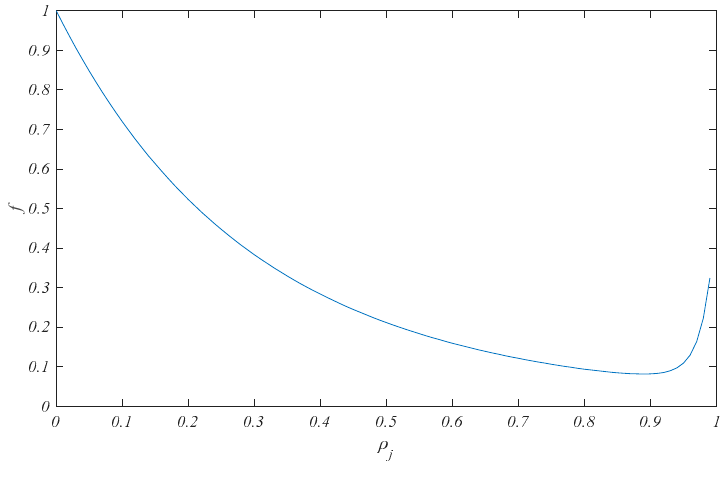
Figure 3. Function image of f with a j = 1 and k 0 = 20.